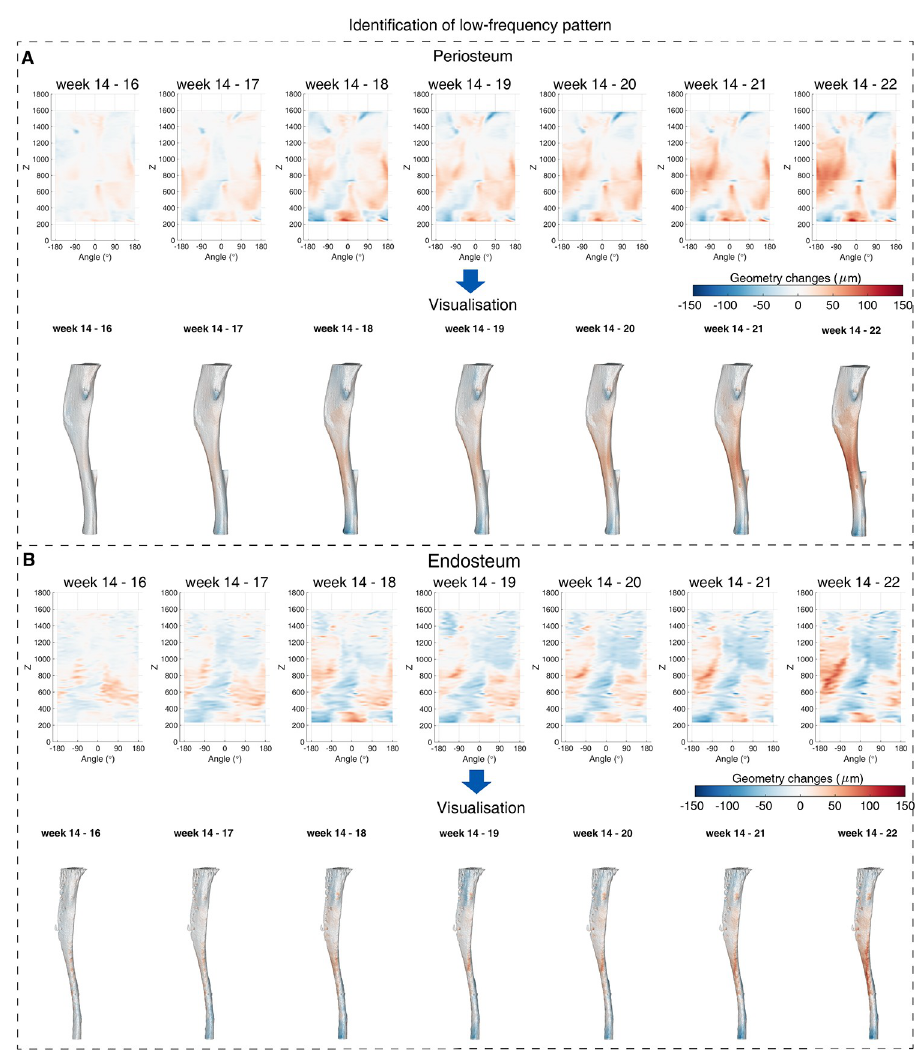
low frequency patterns on endosteum (Top) and the corresponding visualisation (Bottom). In sub-figures, the patterns from left to right correspond to the geometric changes from week 14 to week